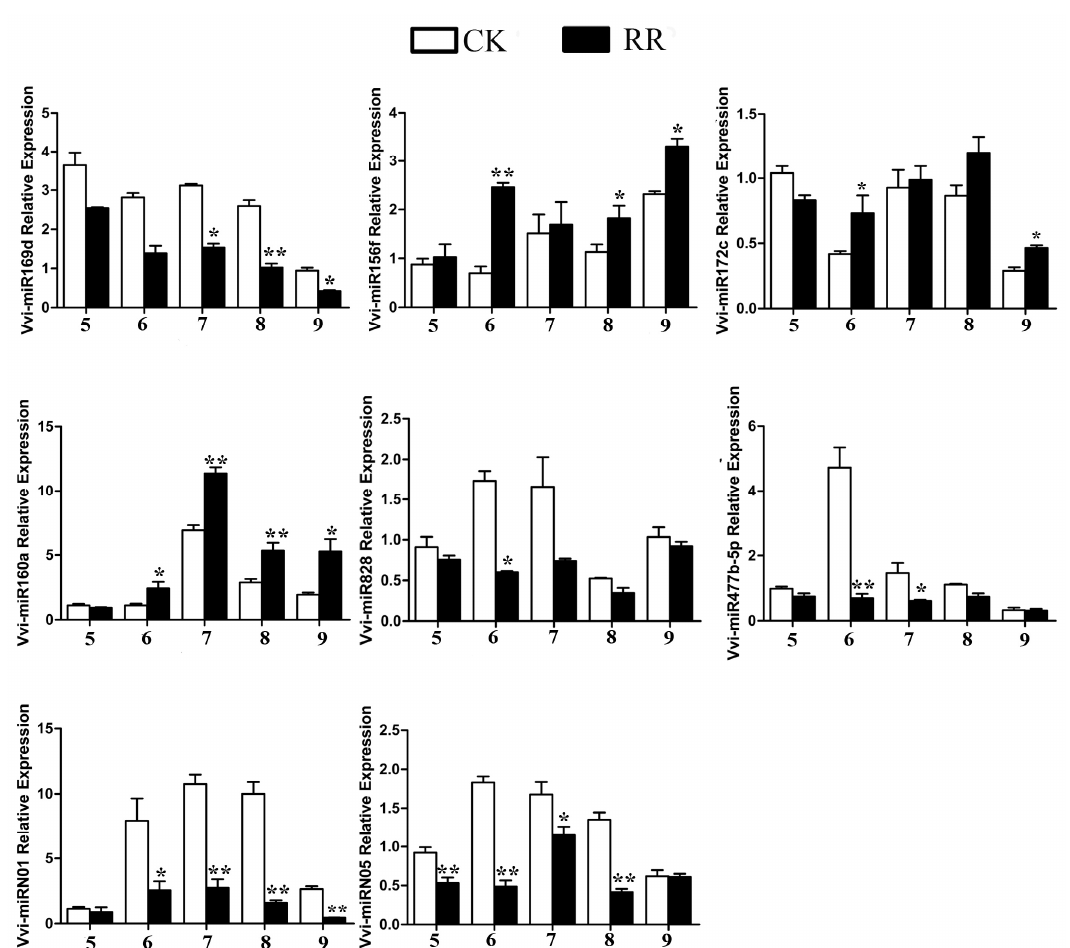
Figure 6. Validation and expression analysis of selected di ff erentially expressed miRNAs derived from high throughput sequencing by tail-tailed qRT-PCR. * p < 0.05 and ** p < 0.01 respectively according to the two-tailed Student’s t -test. Error bars show the standard error between three biological replicates ( n = 3). 5–9 indicate that the sample collection time is 14 July, 18 July, 23 July, 1 August, and 9 August 2017, respectively.